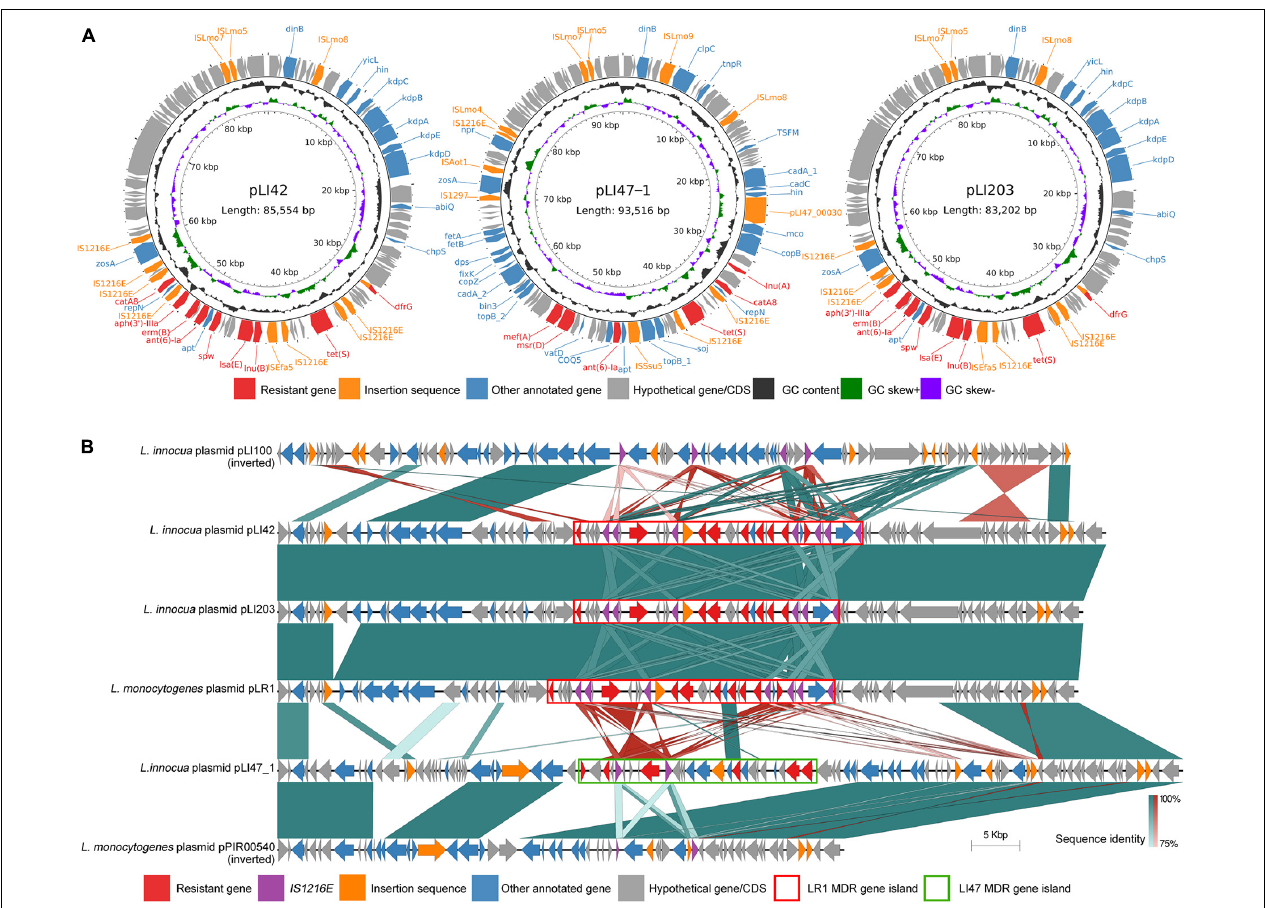
FIGURE 1 | Circular schematic map and linear sequence comparison of three plasmids carrying antibiotic resistance genes. (A) The sequence structure of three sequenced L. innocua plasmid pLI42, pLI47-1, and PLI203. CDSs were shown as arrows. Antibiotic resistance genes were highlighted as red. Insertion sequences were highlighted by orange. Other annotated genes were denoted by blue. The inner two rings represented GC Skew[(G – C)/(G + C), G and C represents guanine content cytosine content] and GC content. (B) Comparison of three L. innocua plasmid pLI47-1, pLI203, and PLI42 sequences with a closely related reference L. innocua plasmid pLI100 and two L. monocytogenes reference plasmid pLR1 and pPIR00540. CDSs were shown as arrows and colored based on gene functions. Copies of insertion sequence IS 1216E was specially highlighted as purple. Green or red shades between each two sequences represented direct or inverted nucleotide identity between covered regions with at least 75% identity. Reference plasmids pLI100 and pPIR00540 sequences were reversed to be aligned with other sequences. L. monocytogenes LR1 MDR gene island and the orthologs were marked in red frames. L. innocua LI47 MDR gene island was marked in green